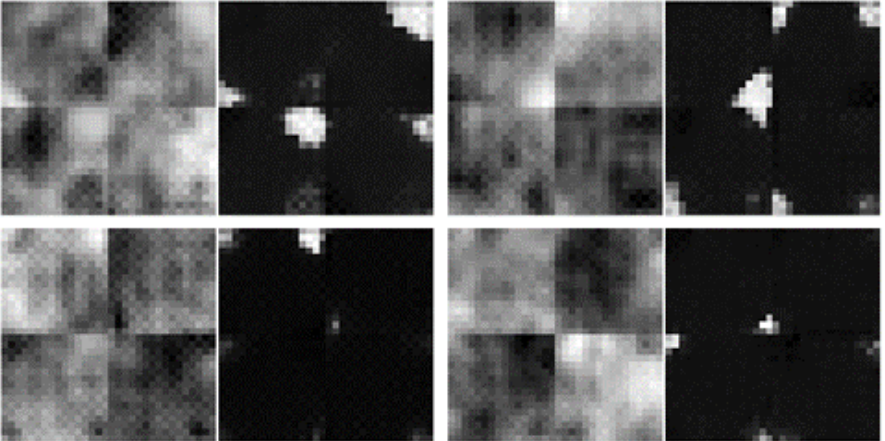
Figure 16. Generated samples are not coherent across the entire 32 × 32 spatial resolution, but only on the 16 × 16